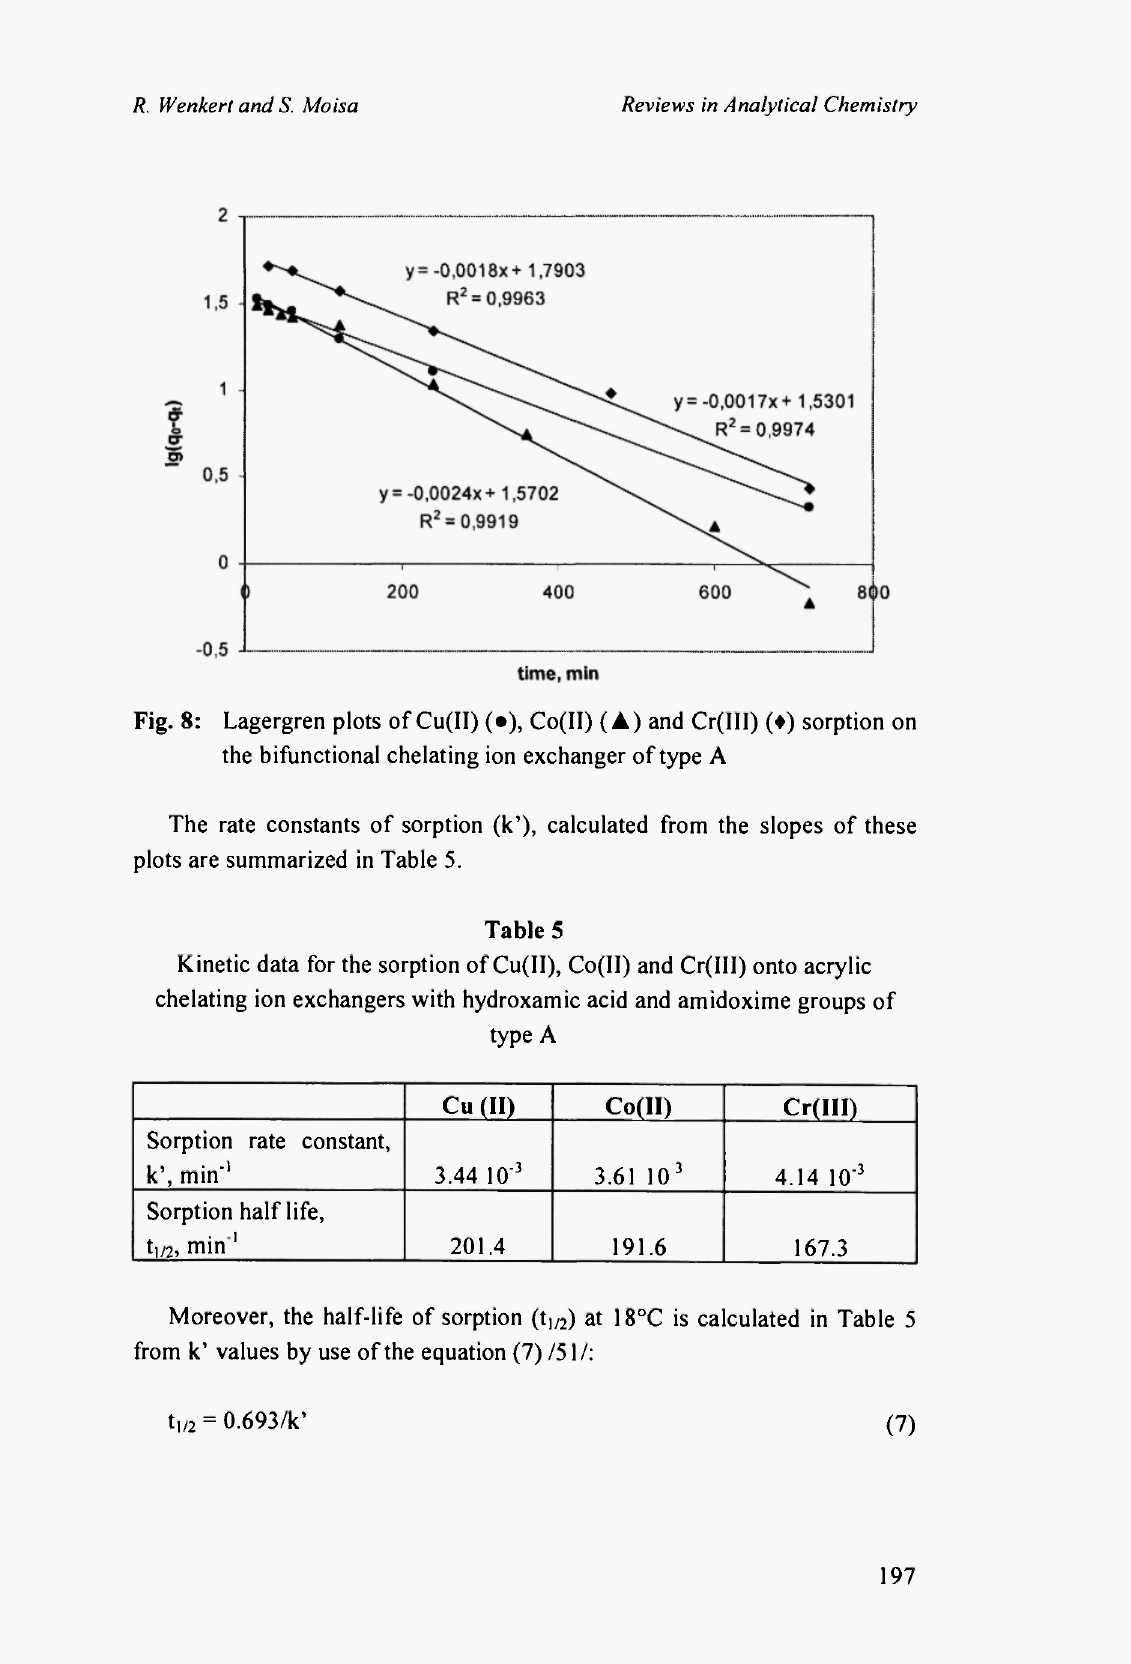
Fig. 8: Lagergren plots ofCu(II) (·), Co(II) (A) and Cr(III) (•) sorption on the bifunctional chelating ion exchanger of type A The rate constants of sorption (k'), calculated from the slopes of these plots are summarized in Table 5.